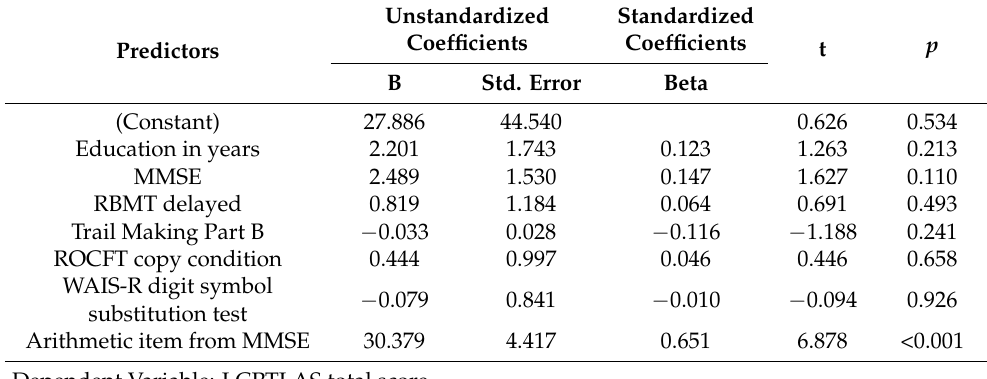
Table 3. Regression of demographic and neuropsychological variables on LCPTLAS total score.